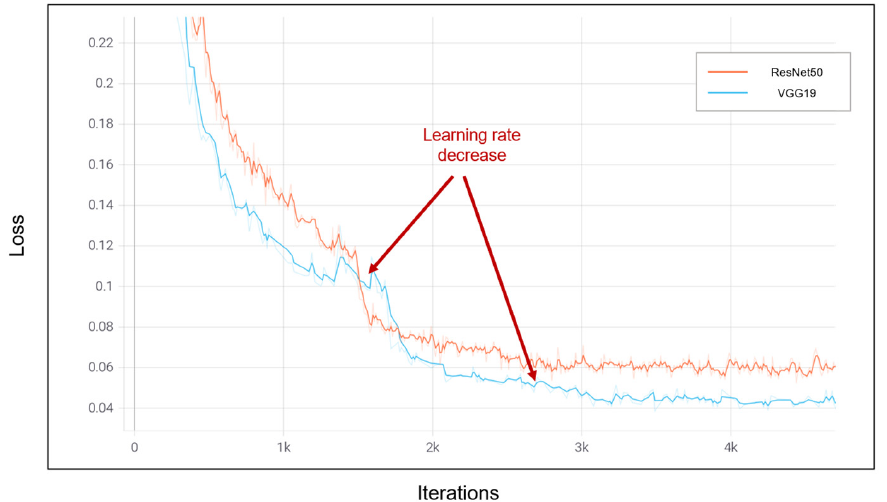
Figure 10. A scaled training loss plots of VGG19 and ResNet50 models. The red arrows refer to the learning rate decrease which result in sudden change in the loss function.